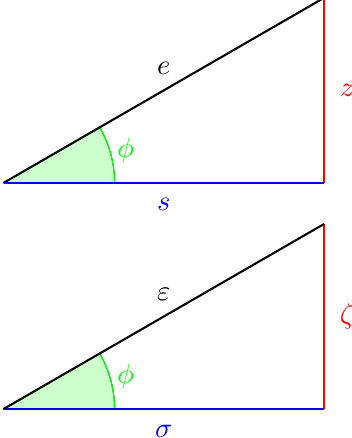
Figure 2: Dimensionless variables (top) e , z and s or (bottom) ε , ζ and σ form a rectangular triangle enclosing angle ϕ . The thixotropy angle ϕ is a degree for the significance of a thixotropic flow regime versus a time-independent flow